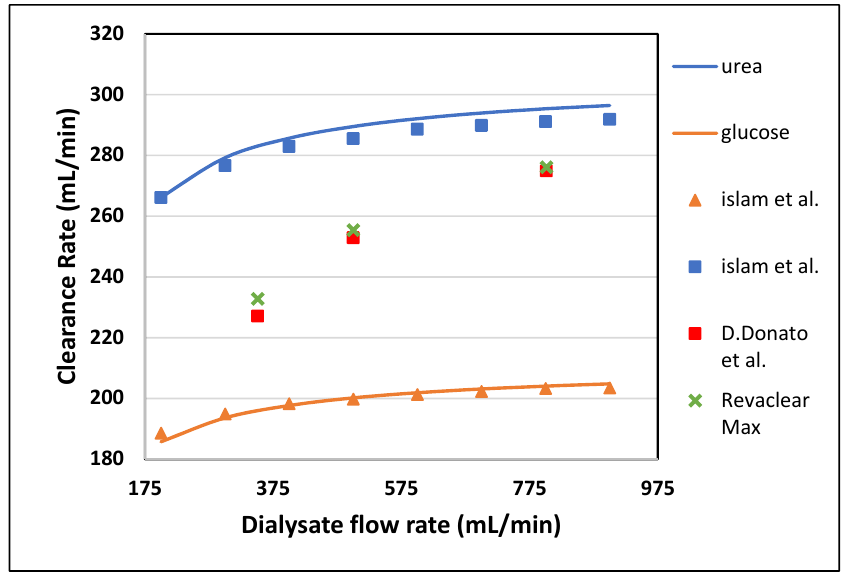
Figure 7. The model predicted (solid lines) vs. in vivo and in silico (symbols) solute clearances plotted against varying dialysate flow rate at Q B = 400 mL/min.